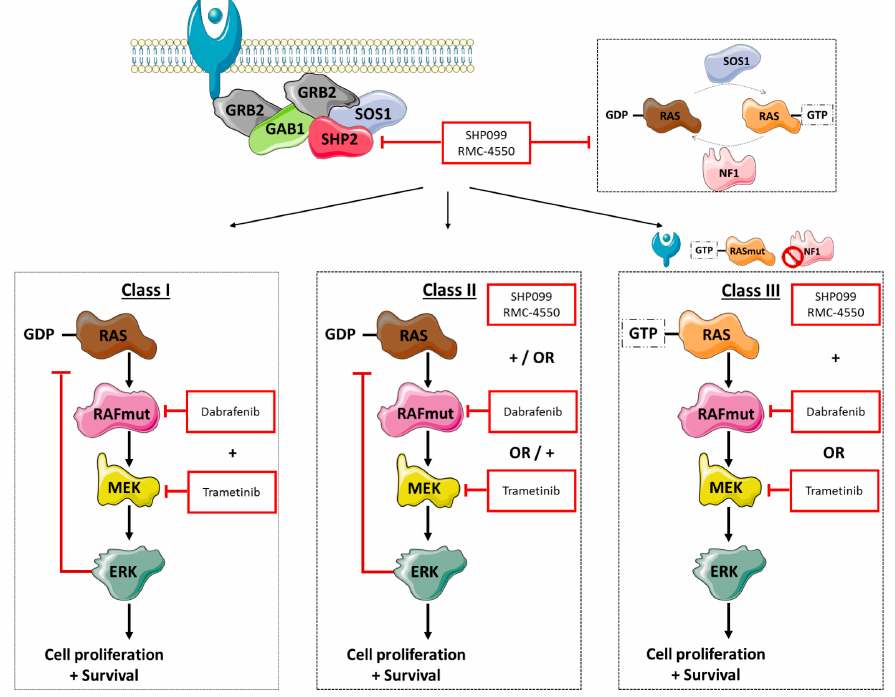
Figure 5. Our model of the BRAF mutation positive mitogen-activated protein kinase (MAPK) pathway signaling mechanisms. Activation of receptor tyrosine kinases (RTKs) leads to stimulation of